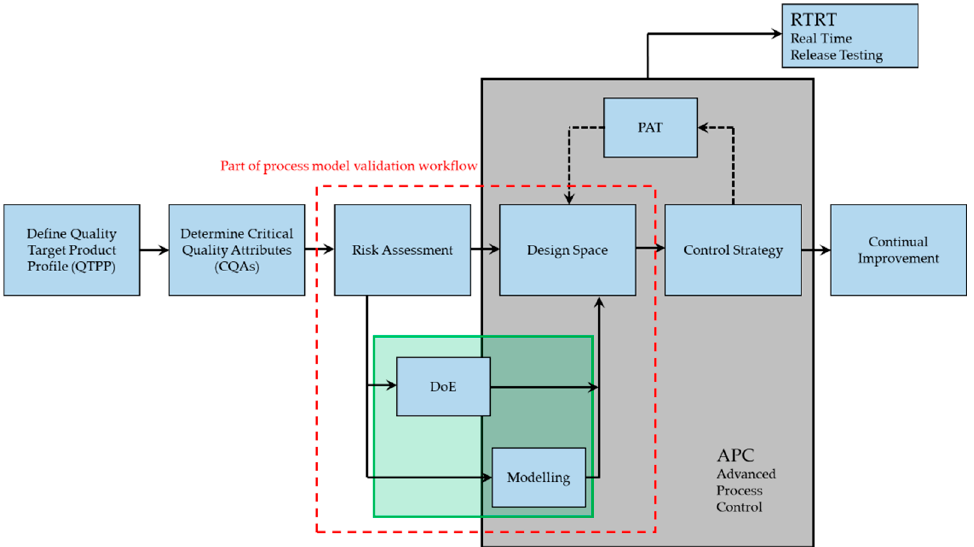
Figure 3. Quality-by-Design based process development strategy [55].